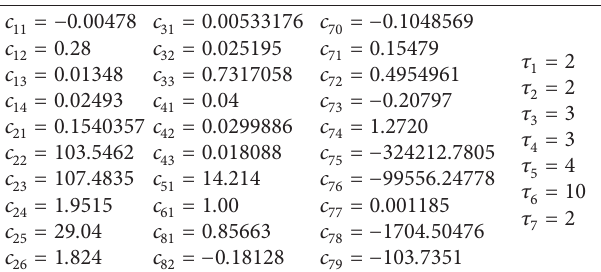
Table 1: Model equations